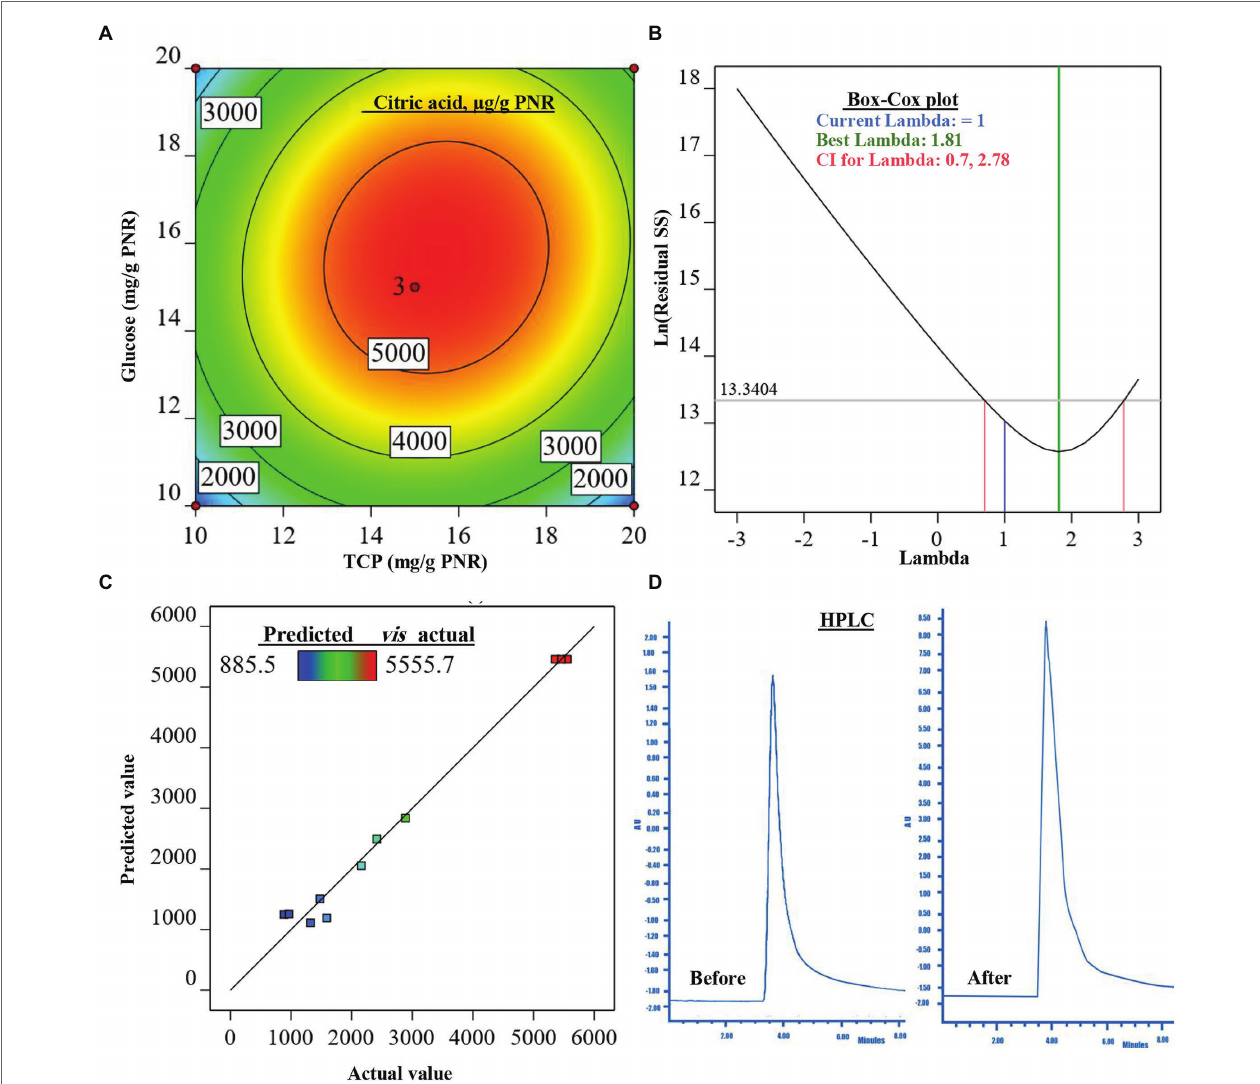
FIGURE 3 | The figure shows the contour plot of citric acid (CA; μ g/g PNR) biosynthesis by Trichoderma sp. WKA55 as a response to the combination of various concentrations of glucose and TCP on a PNR-based medium (A) , the plot of Box-Cox for power transforms (B) , predicted versus actual data of CA (C) , and (D) the diagram of the detected CA by HPLC, before and after the optimization